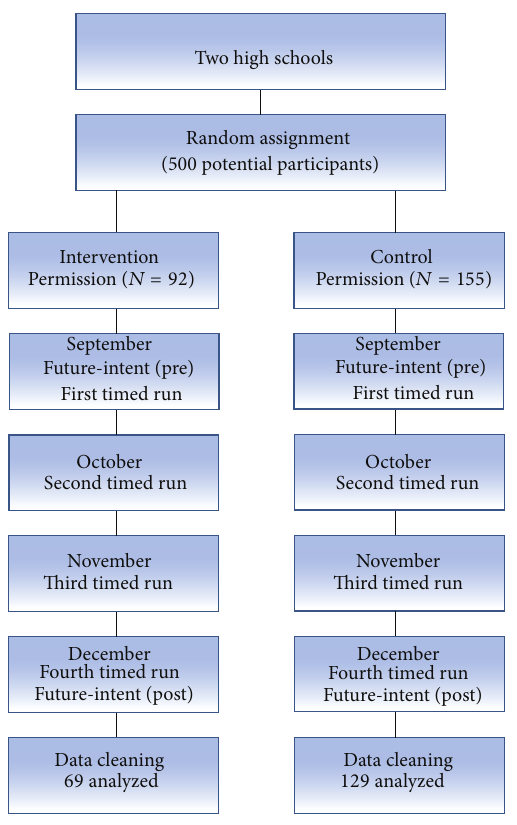
Figure 1: Data collection flow